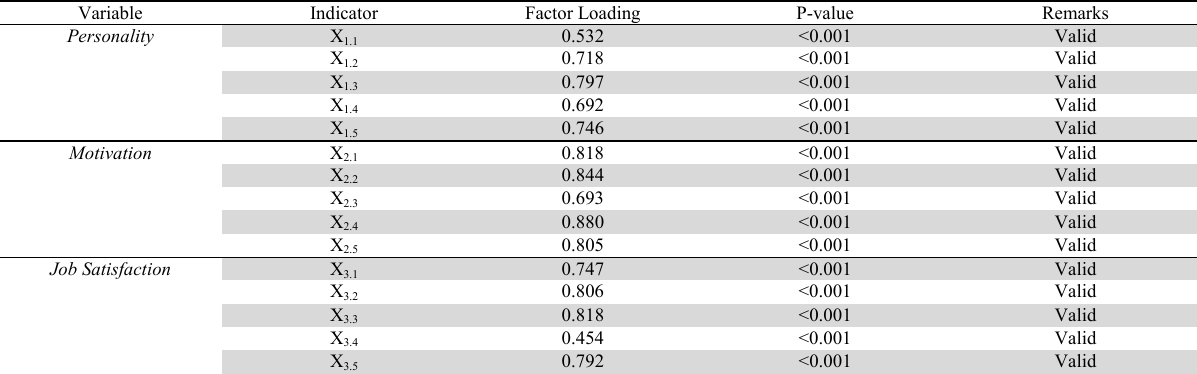
The test result of convergent validity